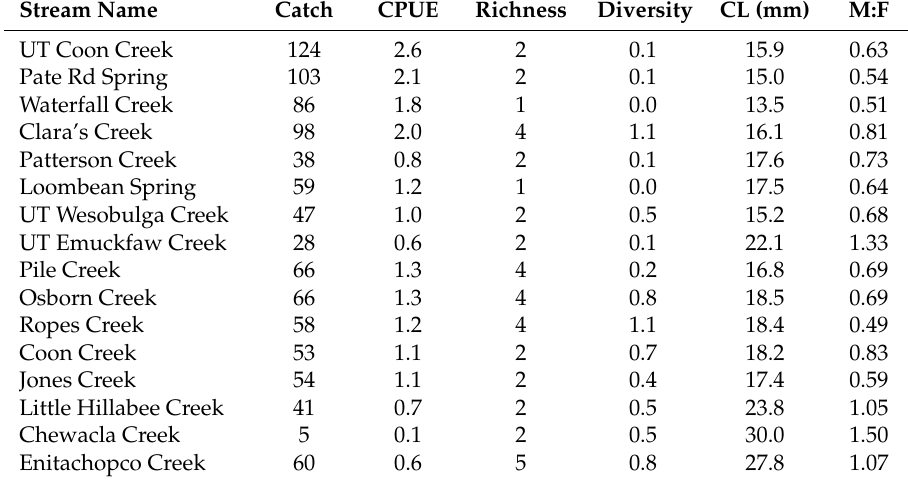
Table 7. Total catch, CPUE (crayfish/m 2 ), species richness, diversity (Shannon’s H’ ), carapace length (CL), and male:female ratios (M:F) for crayfishes in Alabama reference